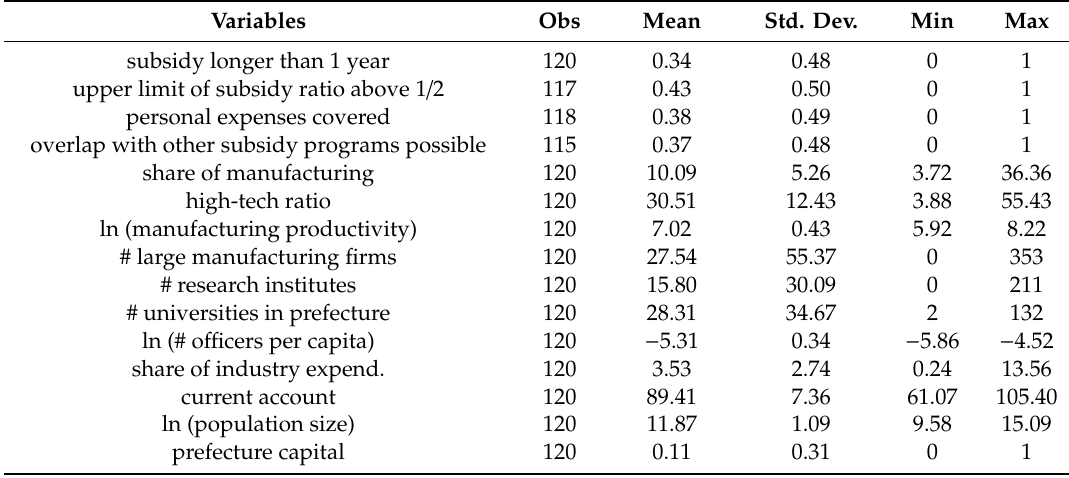
Table 4. Basic statistics of cities that implemented R&D subsidy programs in 2015. Variables Obs Mean Std.